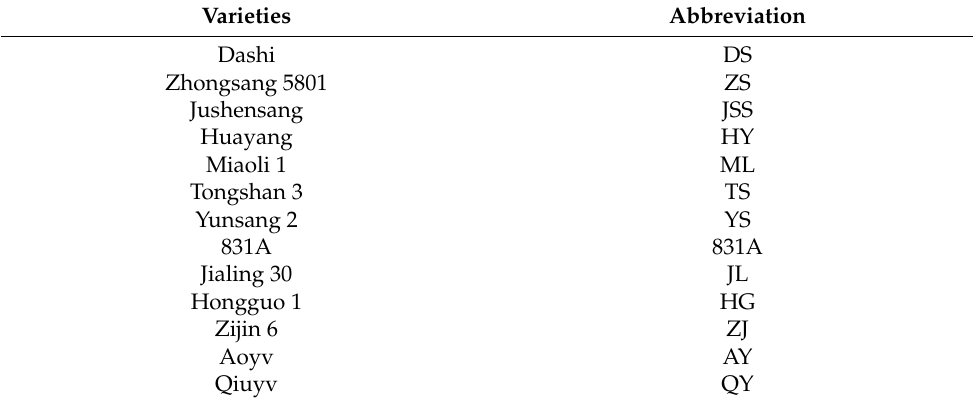
Table 1. An abbreviated list of variety names of mulberry fruits. Varieties